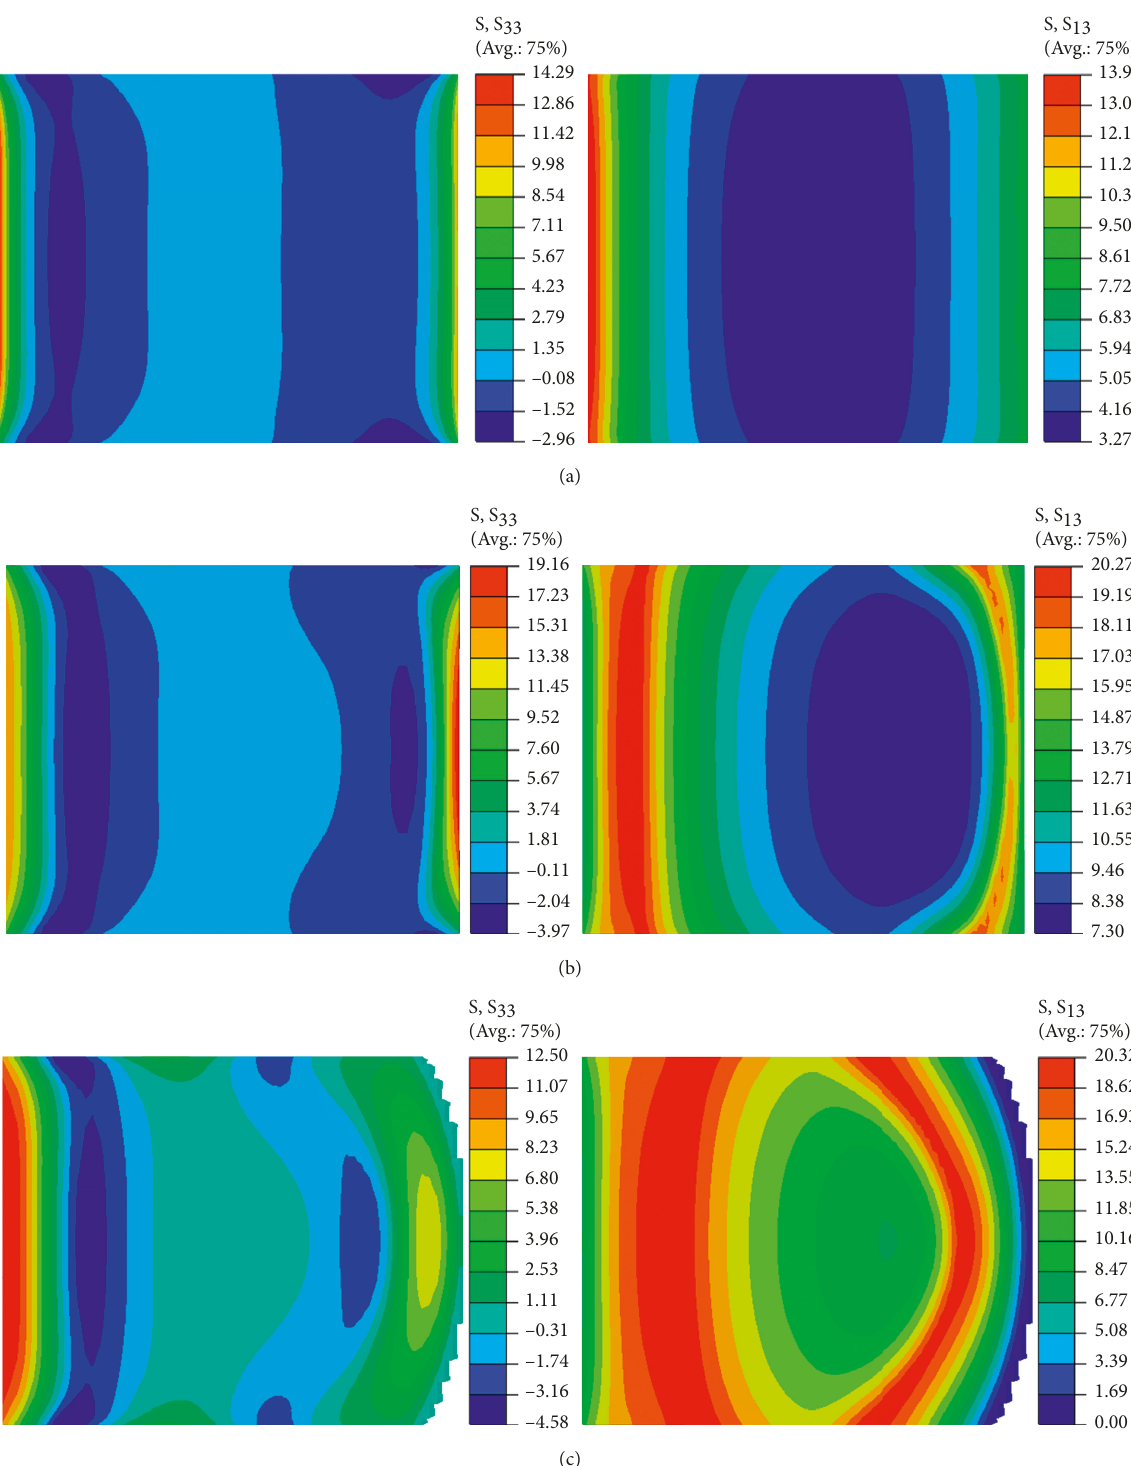
Figure 6: Peel and shear stress distributions at three different moments of the joint using 7779 adhesive with 30 mm overlap length. (a) t 6 s; (b) t 49 s; (c) t 110 (cid:30) (cid:30) (cid:30)